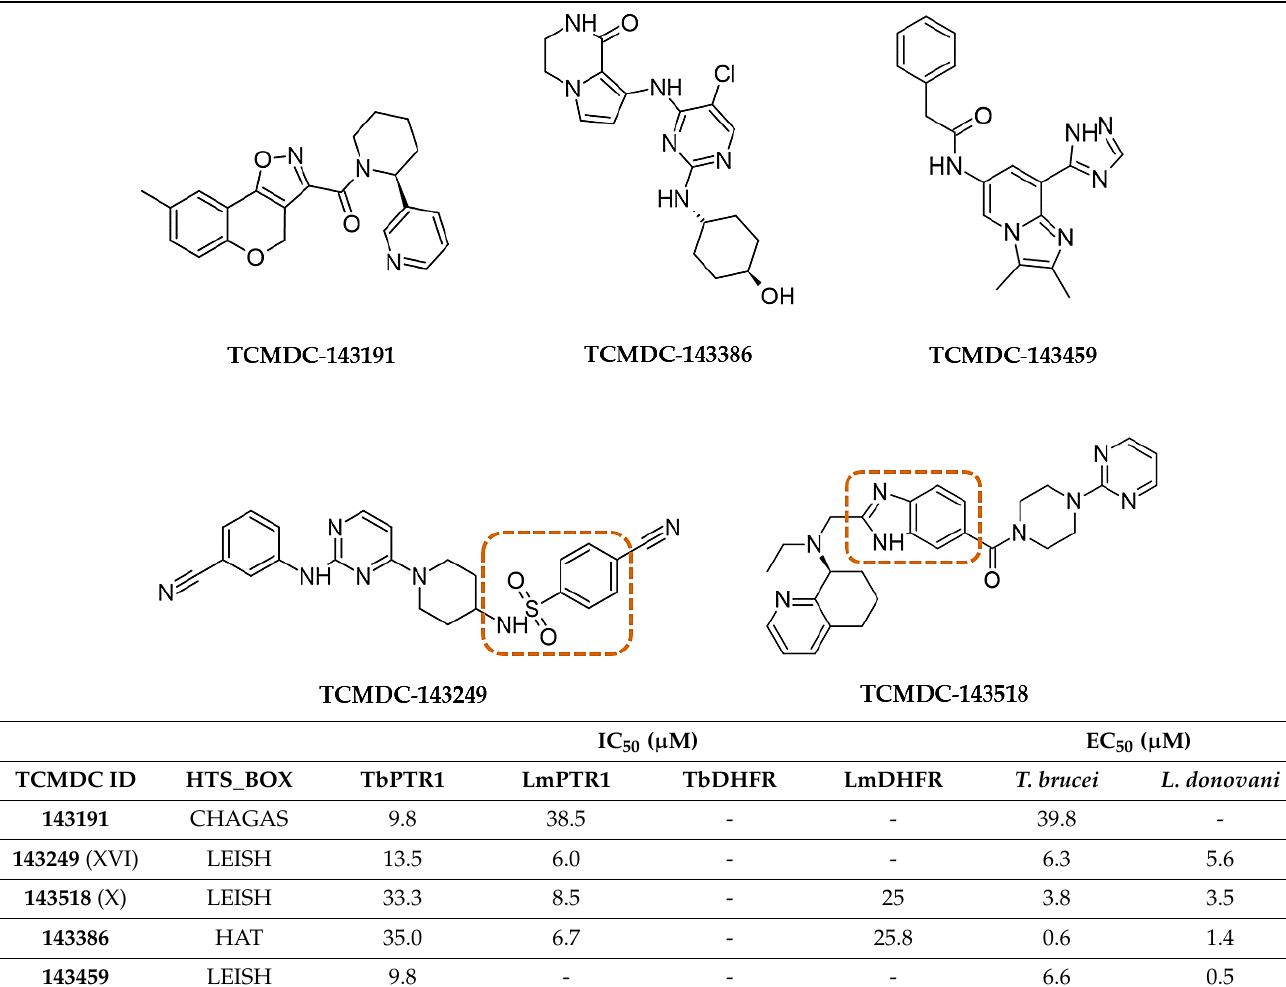
Table 4. Non-antifolate-like scaffolds. Core scaffolds reported in the cluster are highlighted in red boxes.